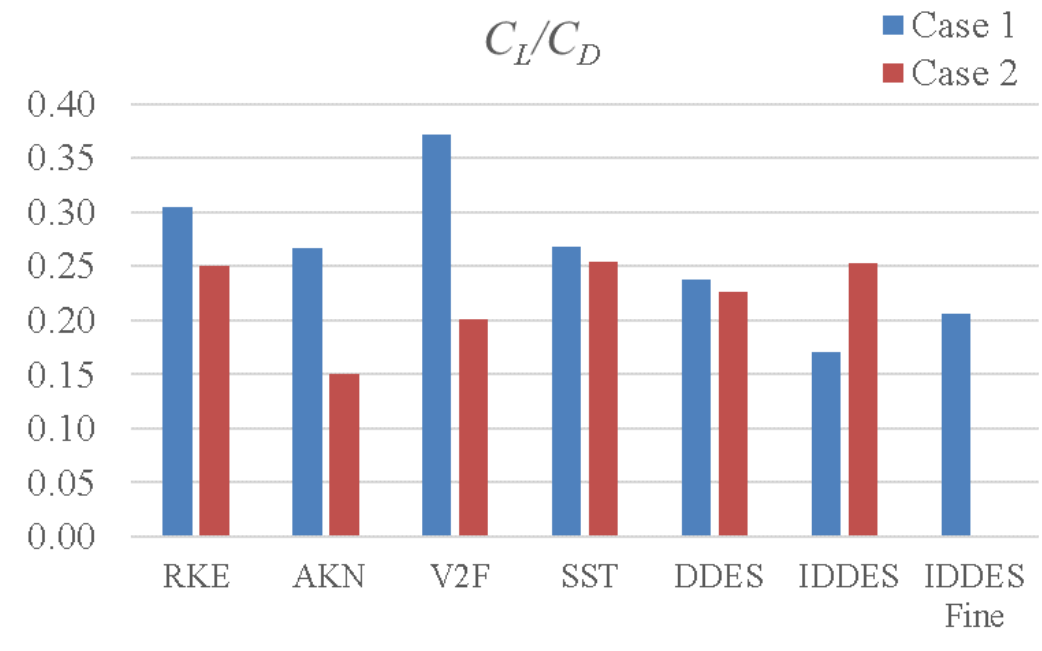
Figure 9. C L / C D for both cases from the predictions of all turbulence